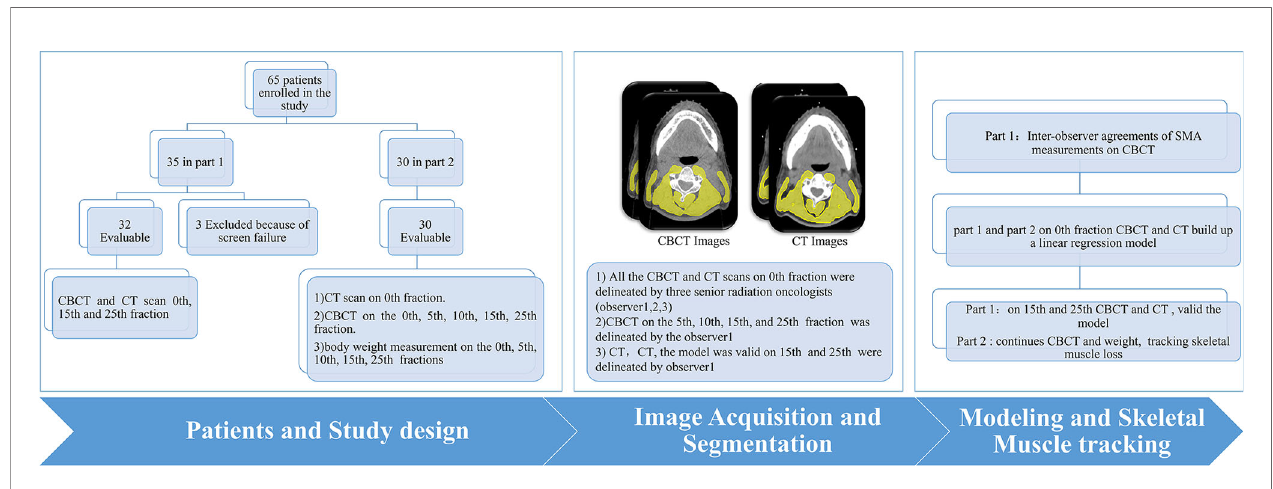
FIGURE 2 | Work fl ow